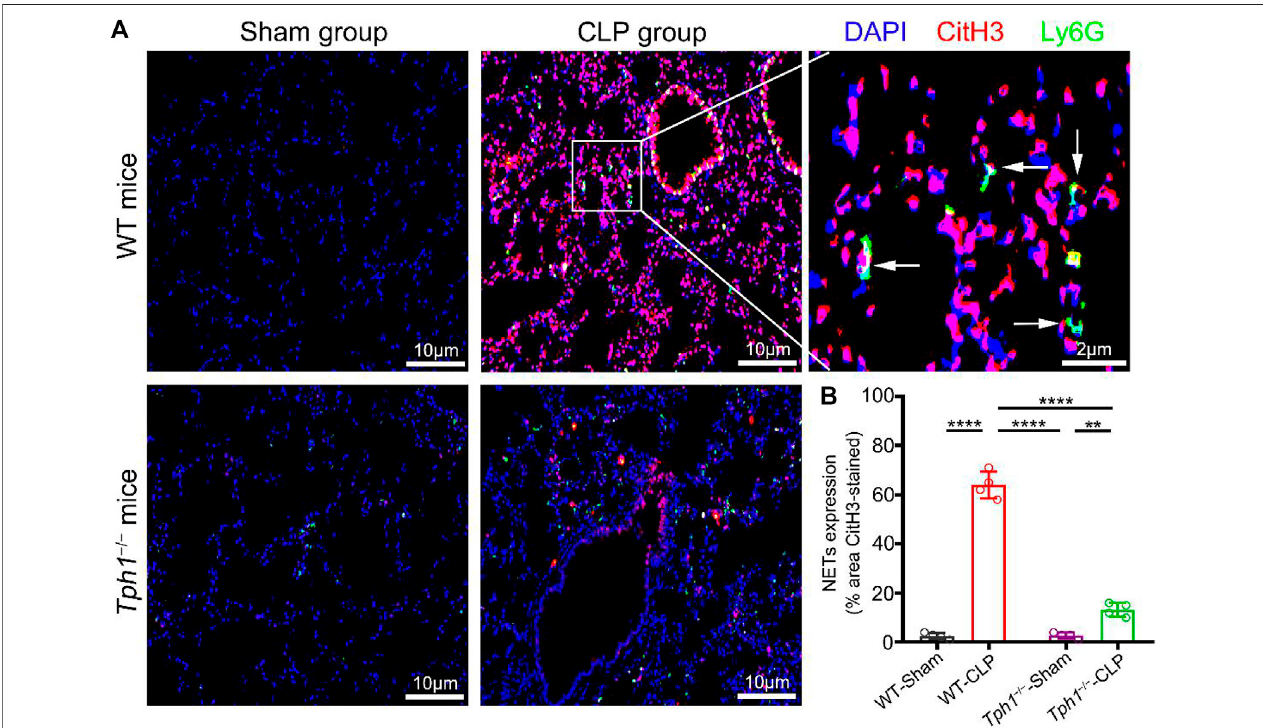
FIGURE2| Peripheral5-HTde fi ciencyinhibitsneutrophilextracellulartrap(NET)formationinthelungofsepticmice.BothWTand Tph1 − / − mice(male,6 – 8 weeks) were selected and randomly divided into sham and CLP groups. The mice were sacri fi ced 12 h after surgery, and lung specimens were collected and co-stained with Ly6G, CitH3, and DAPI fl uorescent antibodies. The accumulation of NETs was detected by immuno fl uorescence microscopy. (A) Representative images of NET formation in the lung of septic mice. (B) Analysis of NET expression in mice lung specimens. For each group: n (cid:2) 4. *p < 0.05, **p < 0.01, ***p < 0.001, and ****p < 0.0001.